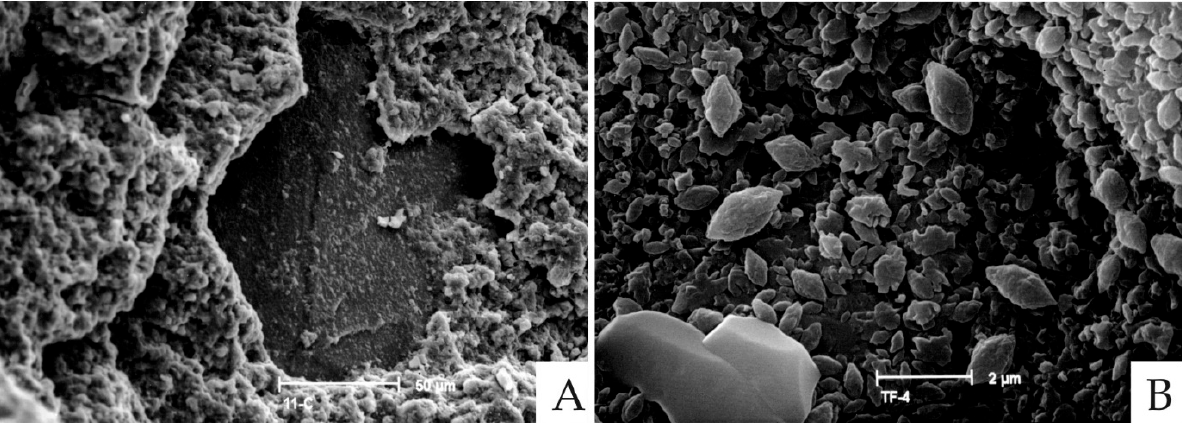
Figure 4. SEM micrographs. ( A ) Detail of stromatolitic calcite layers enveloping grain surfaces (Shelter 11, Peñas de Cabrera). ( B ) Small lenticular gypsum crystals within the stromatolite crust (Cueva del Tajo de las Figuras).